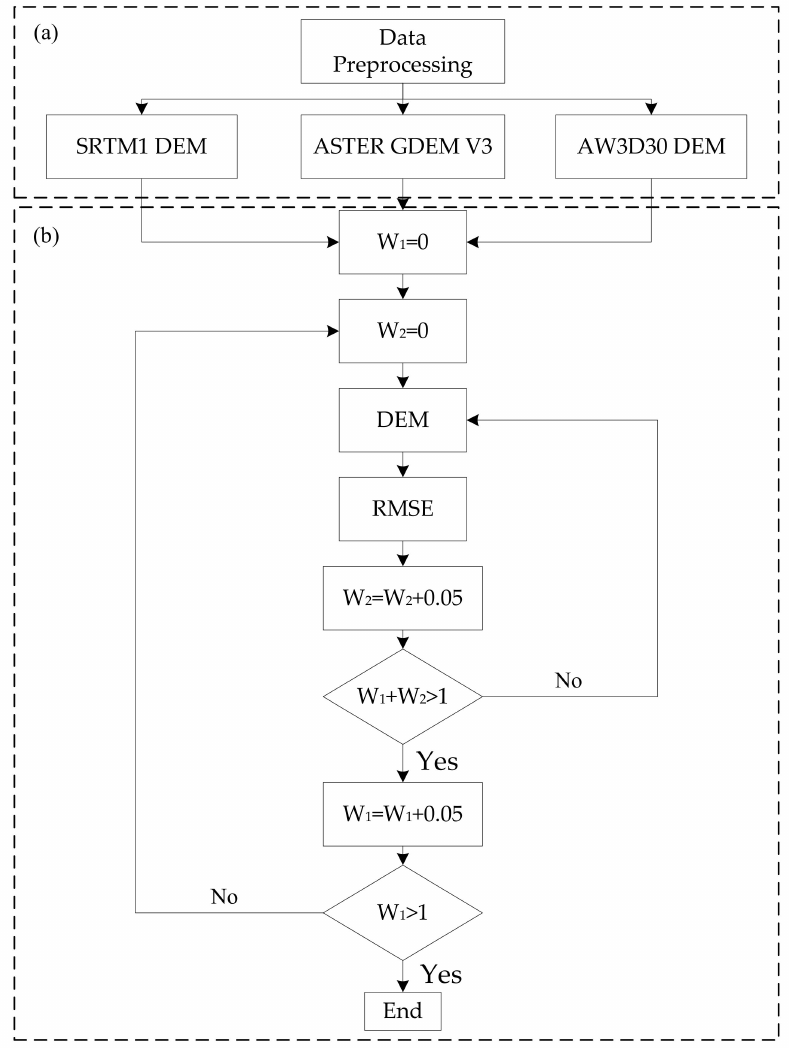
Figure 3. Flowchart for solving the optimal weighting coefficient. ( a ) Data preprocessing; ( b ) Optimal weight